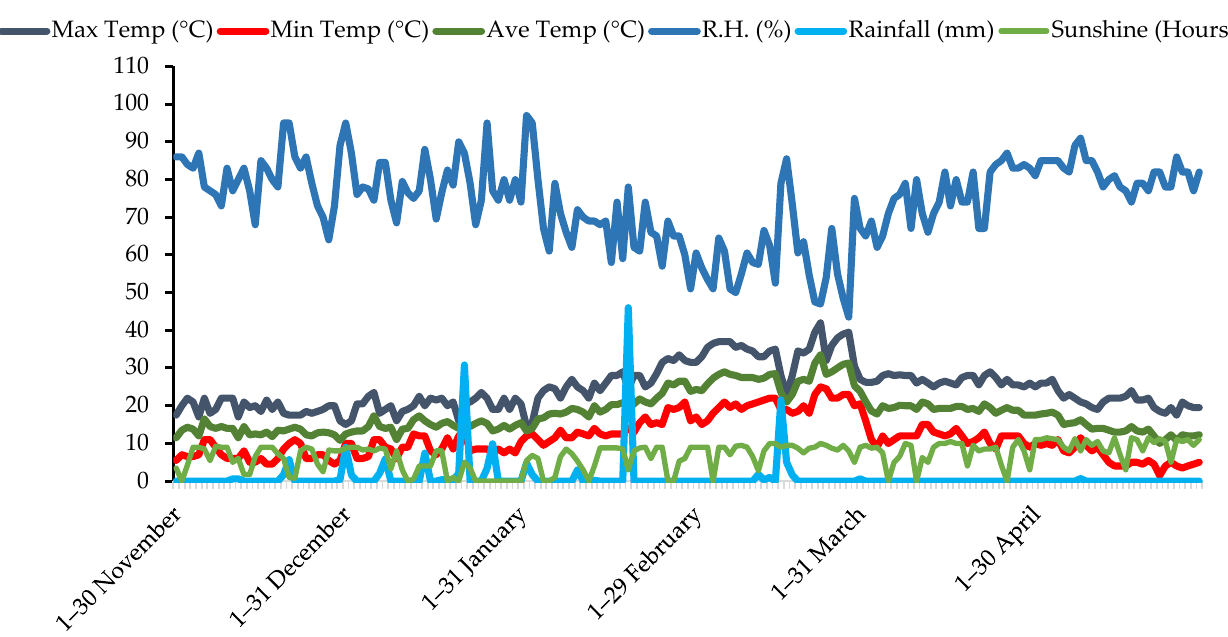
Figure 8. The weather data of experimental station from November 2019 to April 2020 during the growing season of quinoa crop.